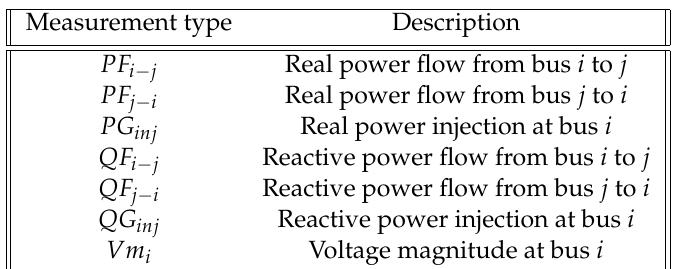
Table 1. Measurement types